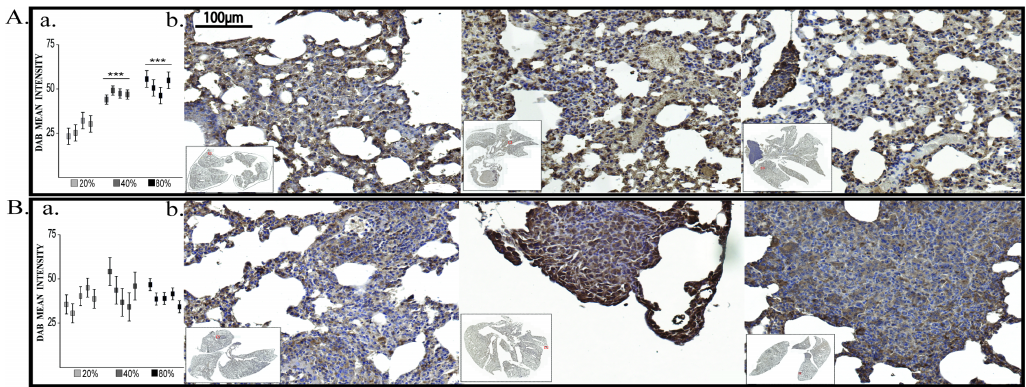
Figure 10. In vivo BDNF protein expression. ( A ) At the end of oxygen exposure (T3) ( B ) At the end of experiment (T4); a. Protein quantification, each data point represent one mouse b. IHC pictures: left G1-21%, middle G2-40%, right G3-80%; Immunofluorescence pictures; *** p < 0.0005.